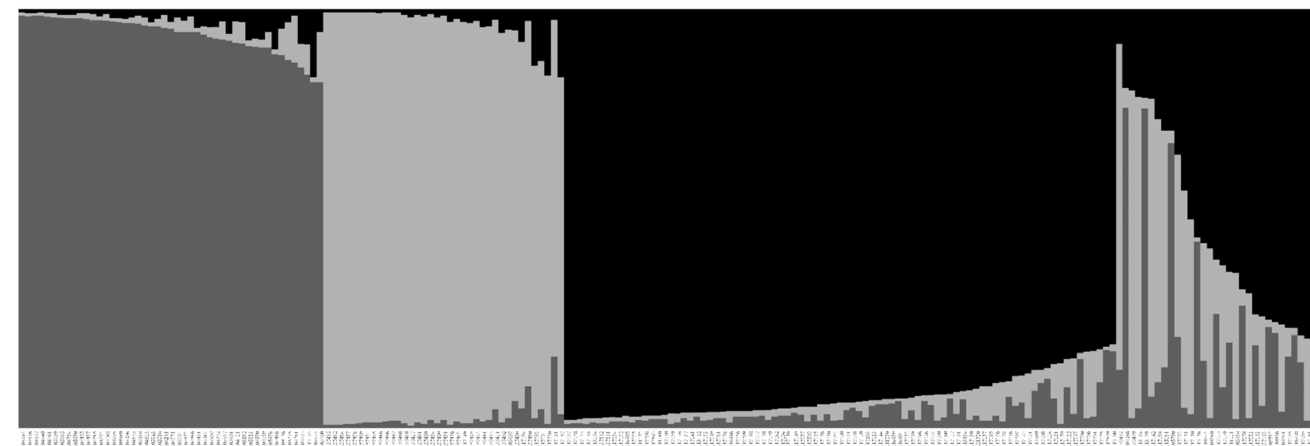
Figure 3. Population structure pattern for the highest ∆ K value ( K = 3) of 200 accessions of native Perilla frutescens var. frutescens of Perilla crop. : Gyeonggi-do, • : Gangwon-do, ♦ : Chungcheong-do, (cid:7) : Jeolla-do, (cid:3) : Gyongsang-do, (cid:4) : (cid:35) other